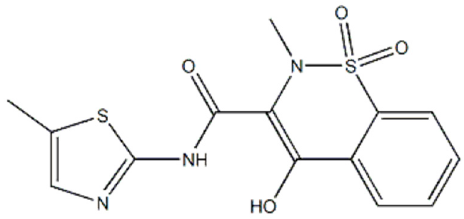
Figure 1. Chemical structure of meloxicam.